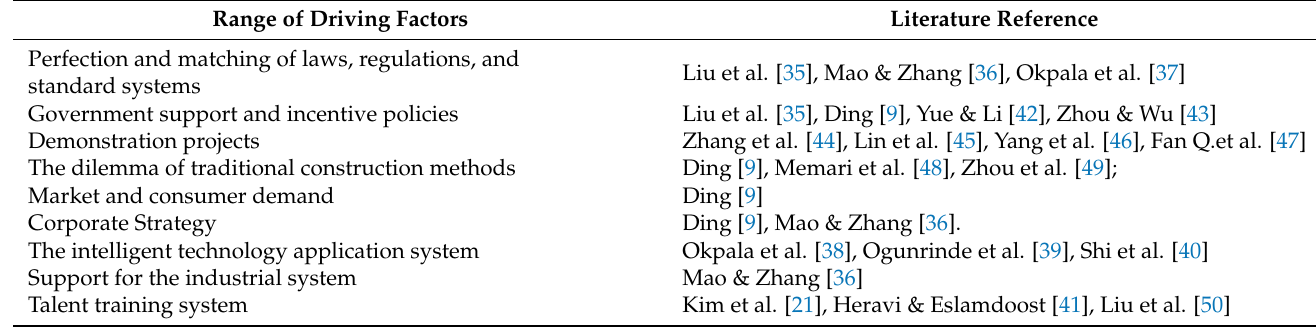
Table 1. Initial list of driving factors for the development of IC from previous studies. Range of Driving